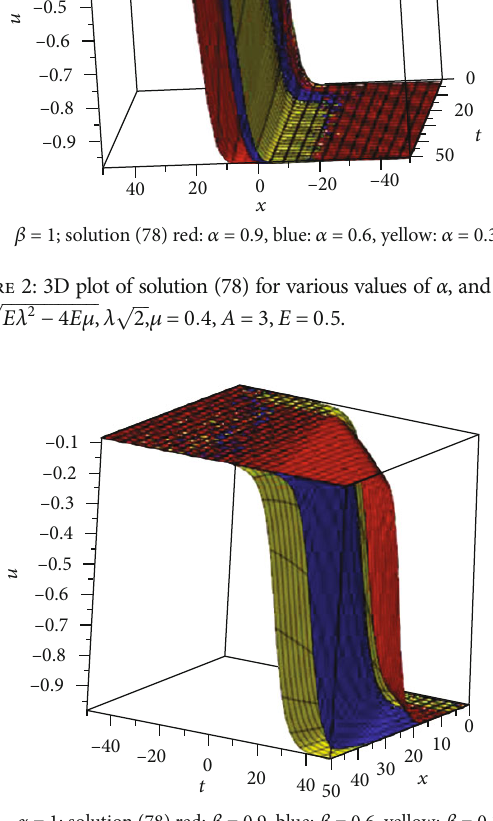
Figure 3: 3D plot of solution (78) for various values of β , and α = 1, p ffiffiffiffiffiffiffiffiffiffiffiffiffiffiffiffiffiffiffiffi ffiffiffi p , λ 2 , μ = 0 : 4, A = 3, E = 0 : 5 c = E λ 2 − 4 E μ